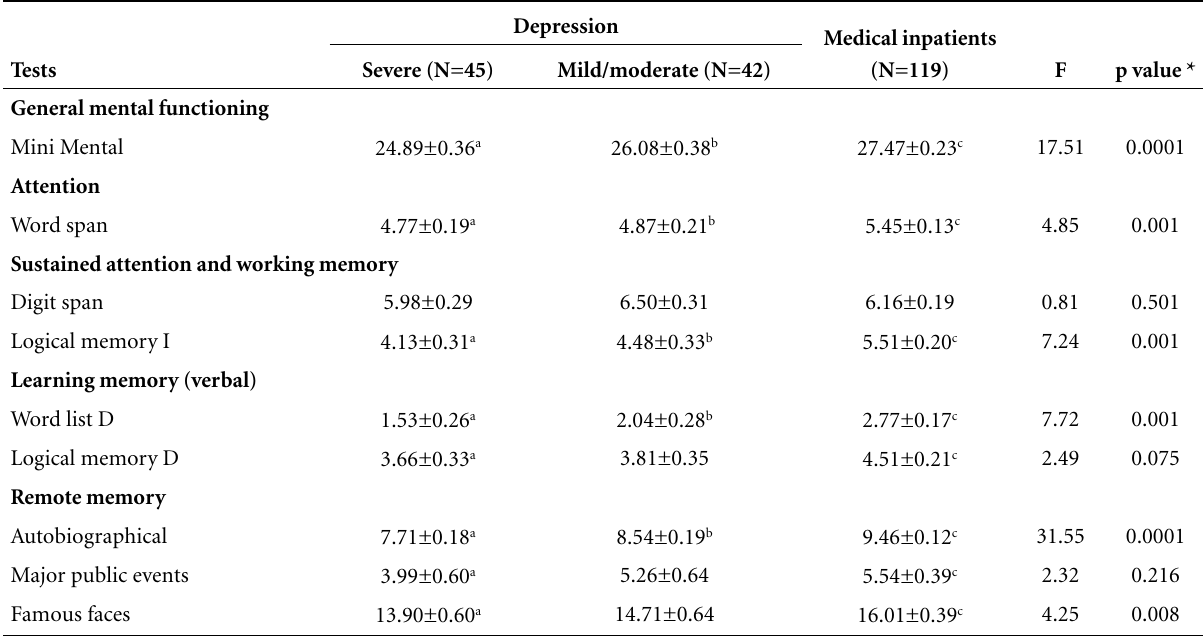
Table 2. Mean±standard error of test scores of studied groups and frequency of cognitive deficit – multivariate procedures of MANOVA (adjusted for age and education).